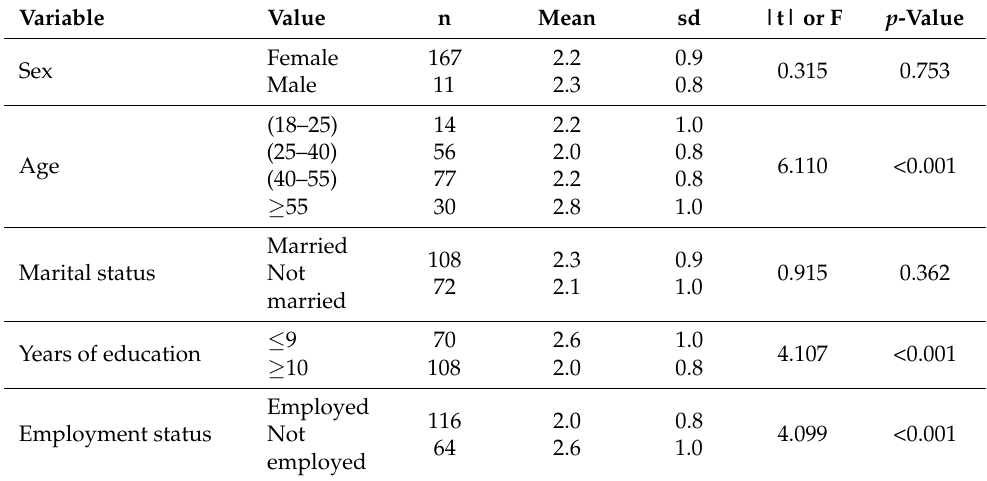
Table 4. SLEQoL total scores for different levels of sociodemographic and clinical variables. Variable